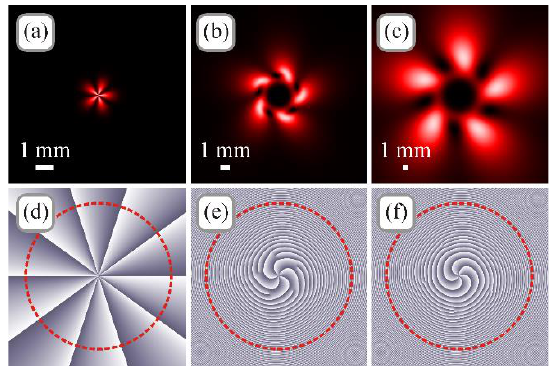
Figure 2. Intensity ( a – c ) and phase ( d – f ) distributions of a superposition of two Gaussian vortices (Equation (18)) in several transverse planes for the following parameters: wavelength λ = 633 nm, waist radius w = 1 mm, topological charges n 1 = 10 and n 2 = 5, superposition coefficients A 1 = 1 and A 2 = 0.5, propagation distances z = 0 ( a , d ), z = z 0 /2 (b,e), and z = 2 z 0 ( c , f ), calculation area − R ≤ x , y ≤ R with R = 5 mm ( a , d ), R = 10 mm ( b , e ), and R = 20 mm ( c , f ). Red circles on the phase distributions are those along which TC (Equation (2)) and invariants (Equations (16) and (17)) were calculated.